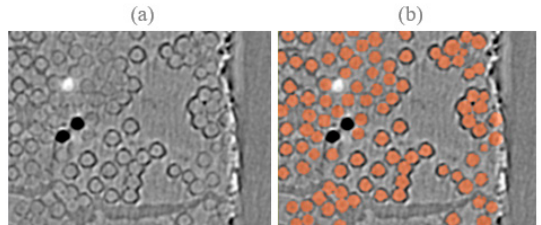
Figure A1. A cropped ( a ) raw ( b ) manually labeled CT image used for deep learning training.